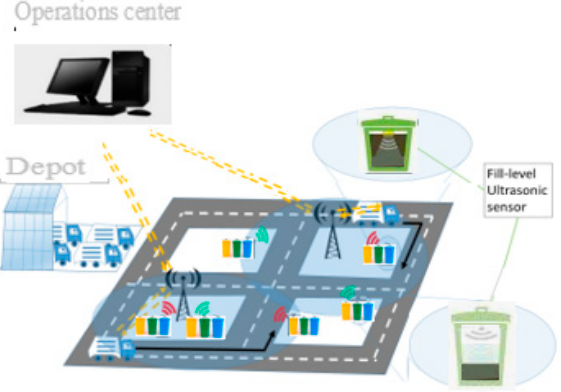
Figure 5. Real-time traceability system.